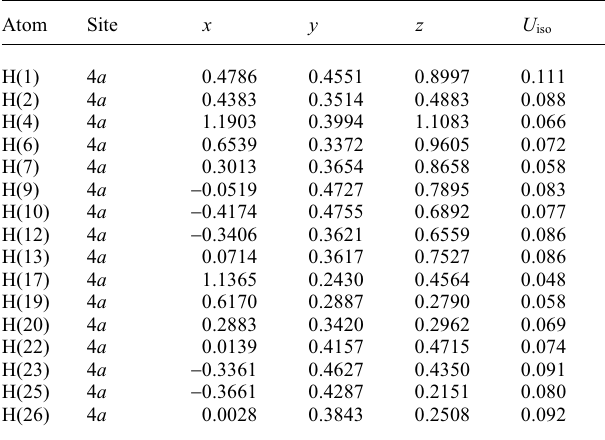
Table 2. Atomic coordinates and displacement parameters (in Å 2 )